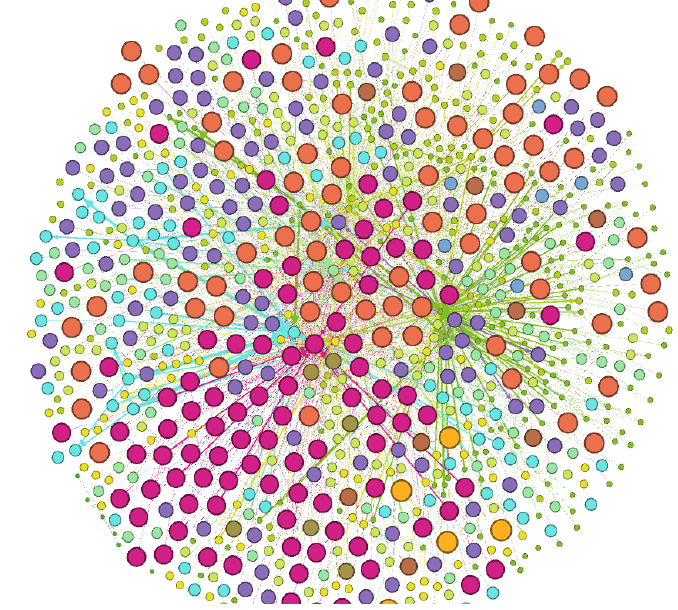
higher modularity class in 12 networks based on the aforementioned parameters. Repul- sion strength was set to 10,000, and Force Atlas and Fruchterman rein gold layouts were used to display and visualize the networks.